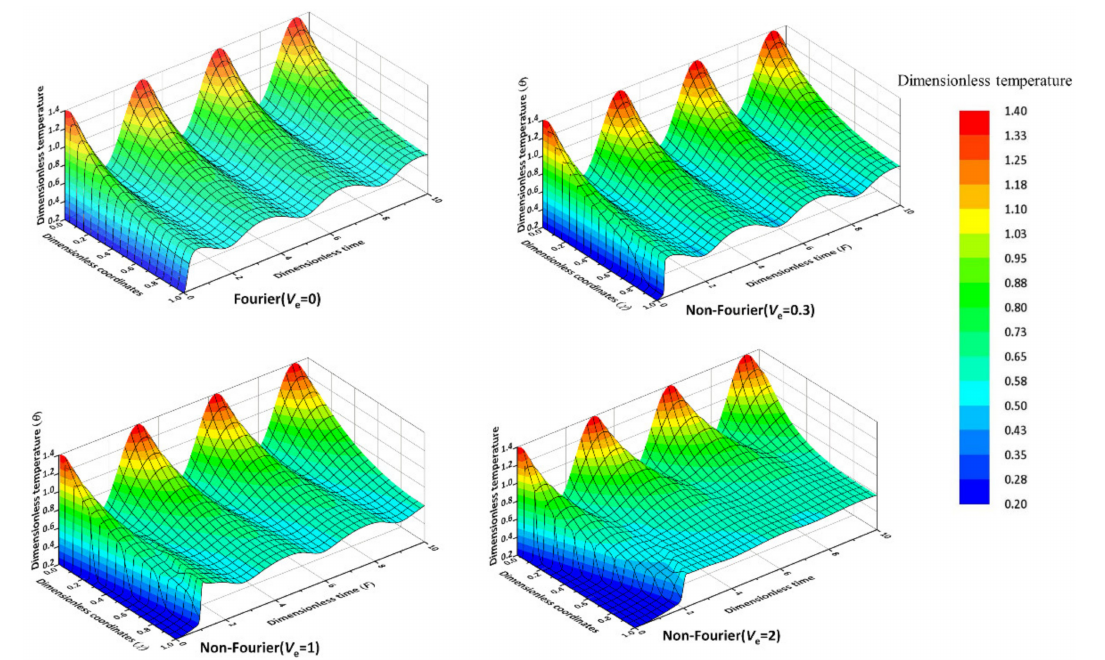
Figure 5. Dimensionless temperature for different values of V e.